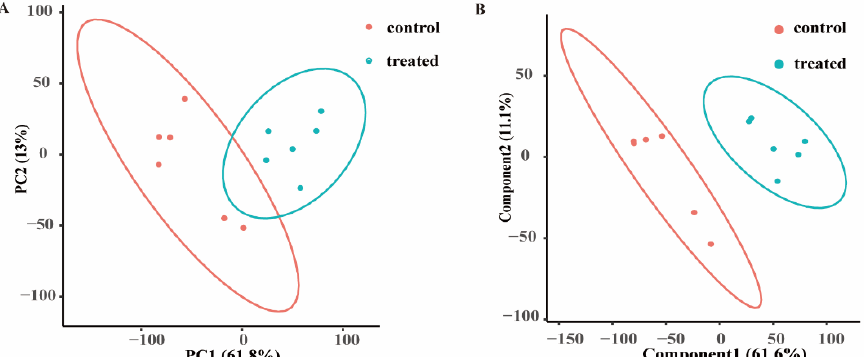
Figure 1. The metabolites in treated group compared to those in control group. ( A ) Principal component analysis (PCA) score plot of metabolite profiles from the treated and control groups. ( B ) Partial least squares discriminant analysis (PLS-DA) score plot of metabolite profiles from the treated and control groups. Each point represents an independent biological replicate. The red dots indicate the control group, the blue dots indicate the treated group.